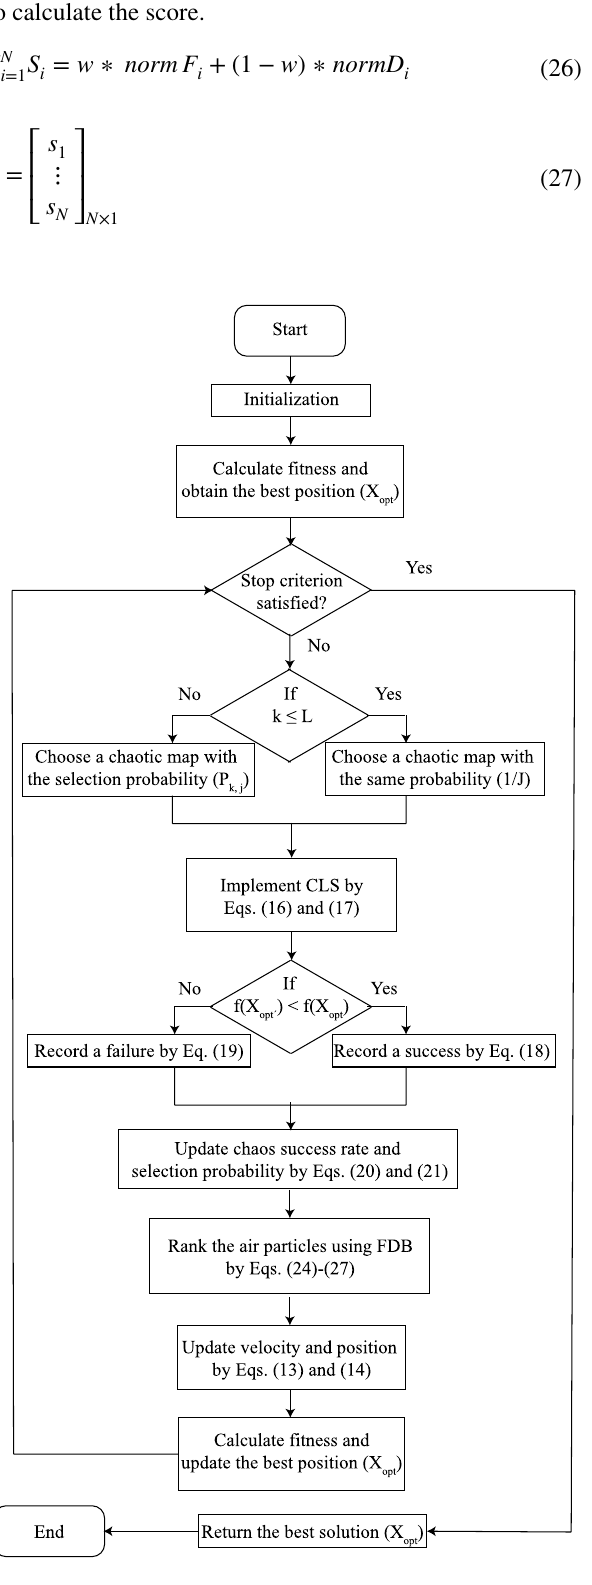
Fig. 2 Flowchart of